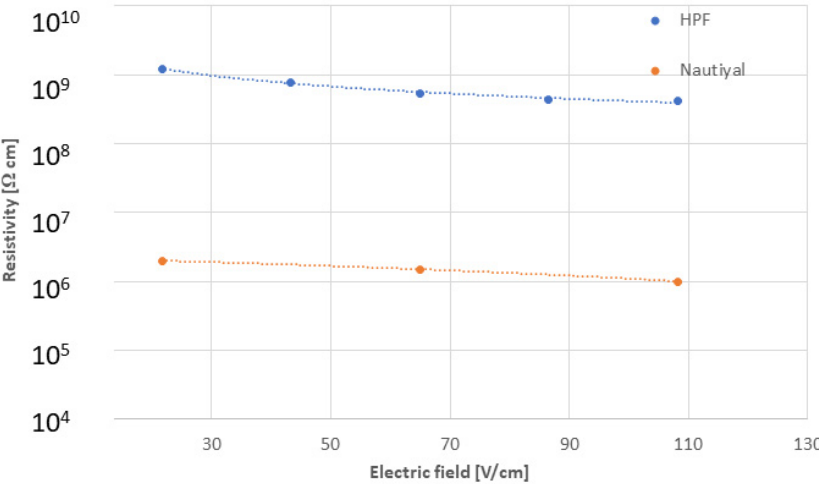
Figure 12. Dependence of the DC resistivity on the applied electric field intensity, in comparison with data reported in [36].